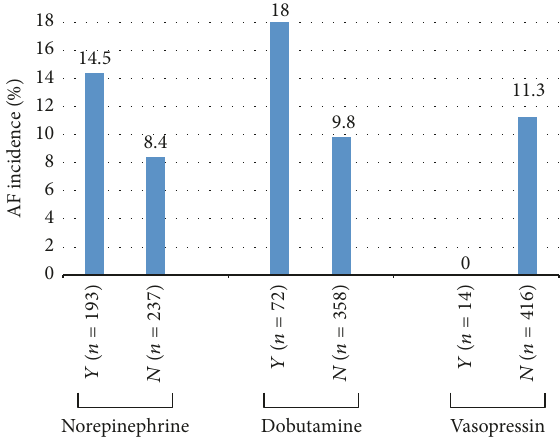
Figure 1: Incidence of AF according to the use of vasoactive drugs